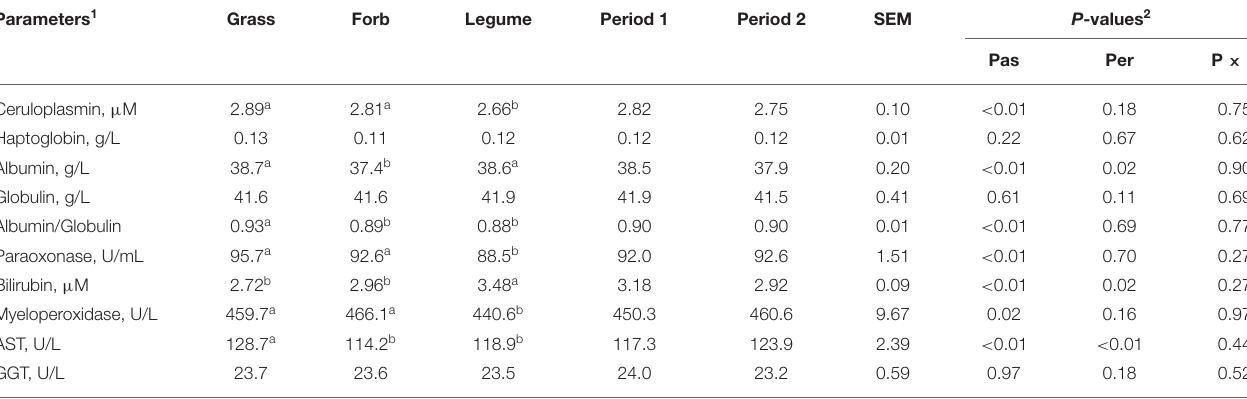
TABLE 2 | The blood parameters associated with inflammation, immune response, and liver health in the dairy cows grazing Grass-, Forb-or Legume-based pastures. Parameters 1